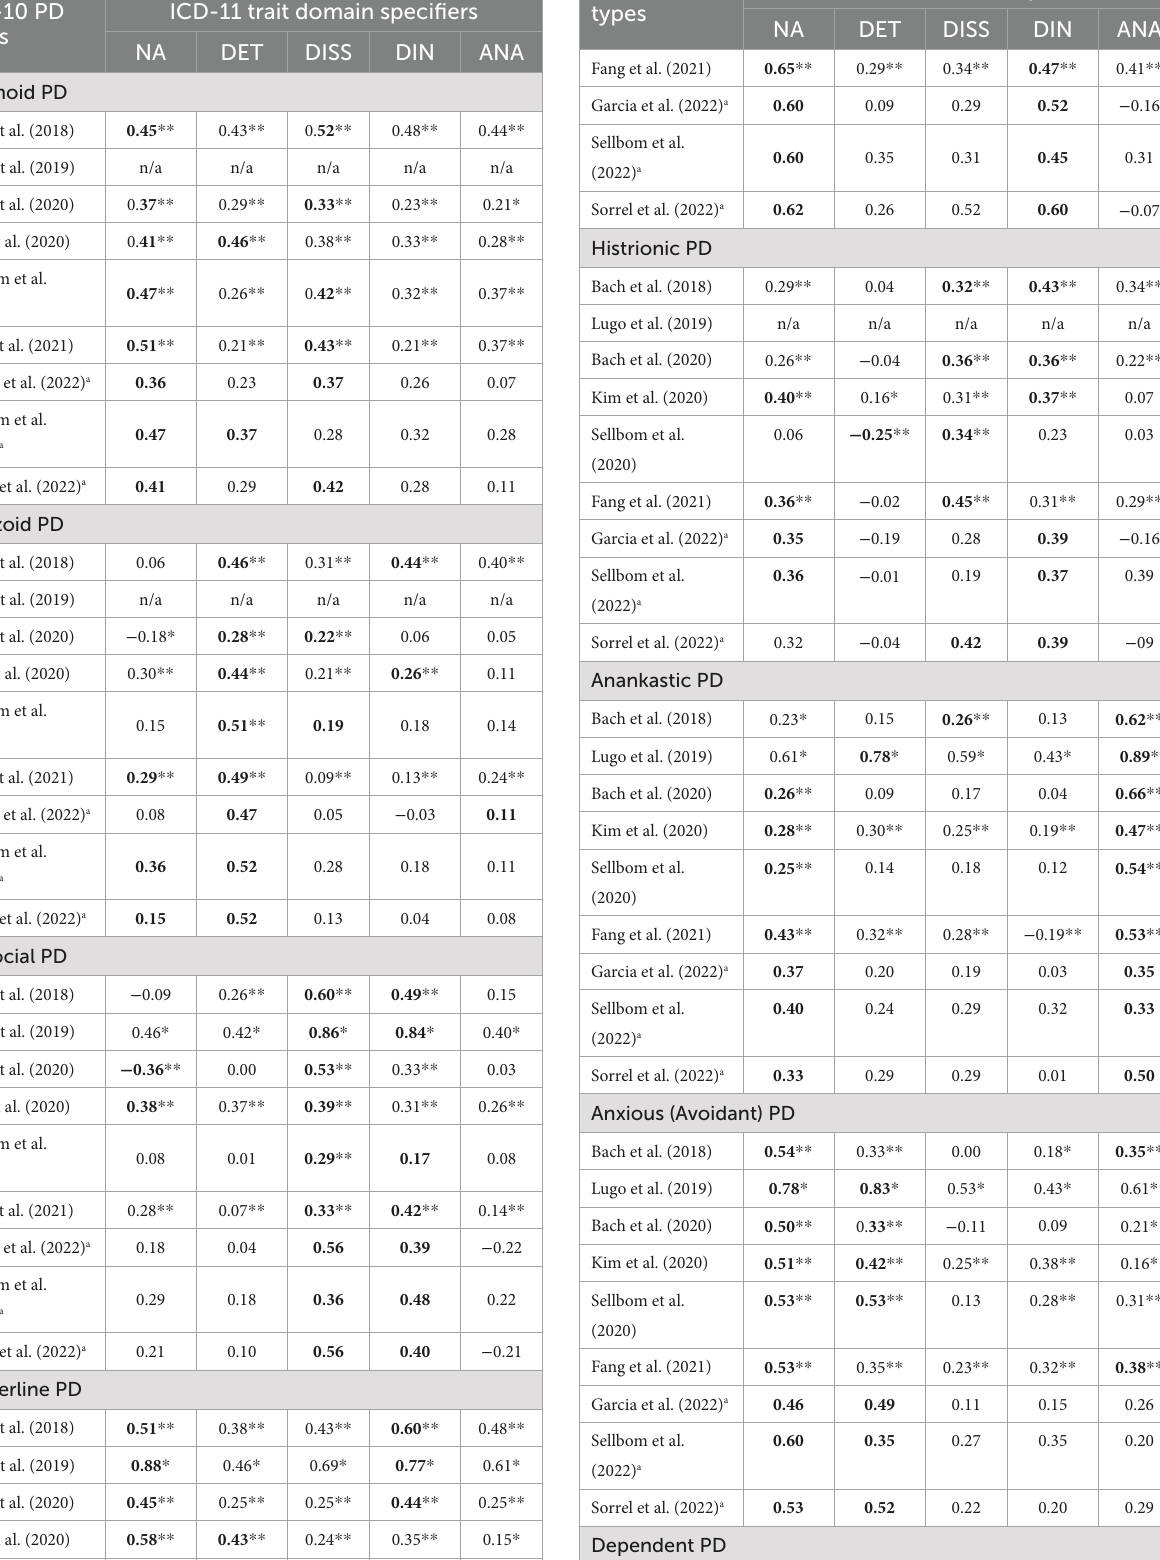
TABLE 2 Associations between personality disorder types and ICD-11 trait domain specifiers across the nine identified studies. ICD-10 PD